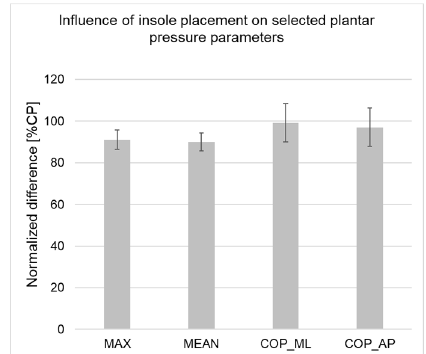
Figure 3. Results for the evaluation of the influence of pressure-sensing insole placement on the selected parameters MAX, MEAN, COP_ML, and COP_AP, including the results of all different running shoes. Bars and error bars show the mean and standard